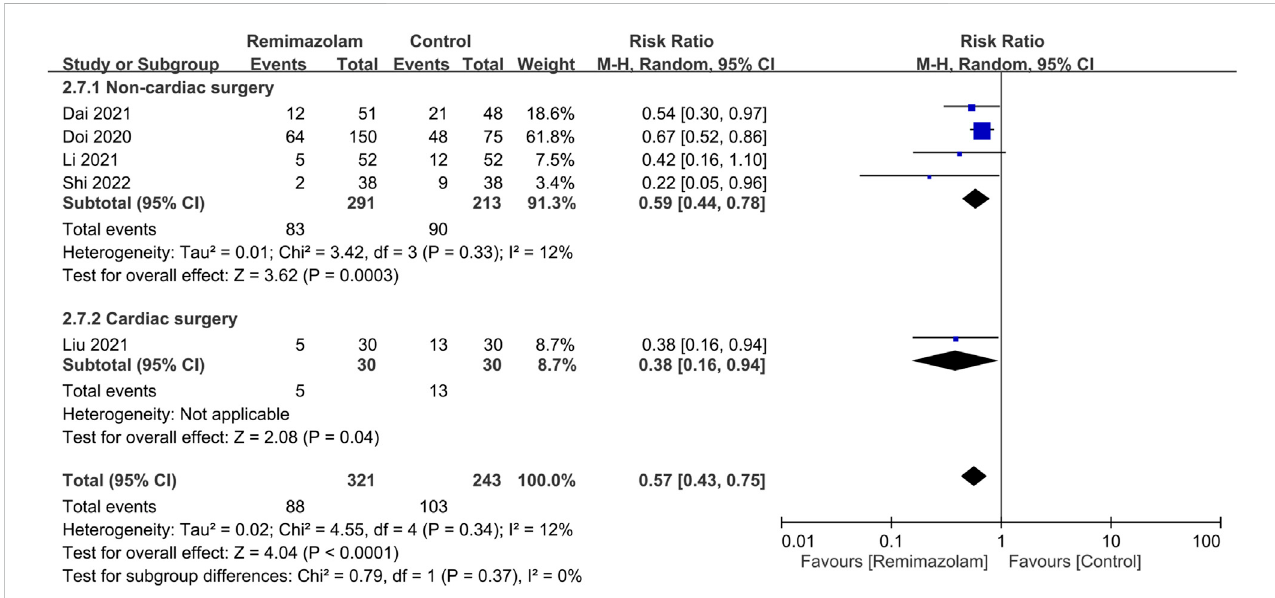
FIGURE 3 Forest plot comparing the risk of hypotension between remimazolam and control groups. M-H, Mantel-Haenszel; CI, con fi dence interval.